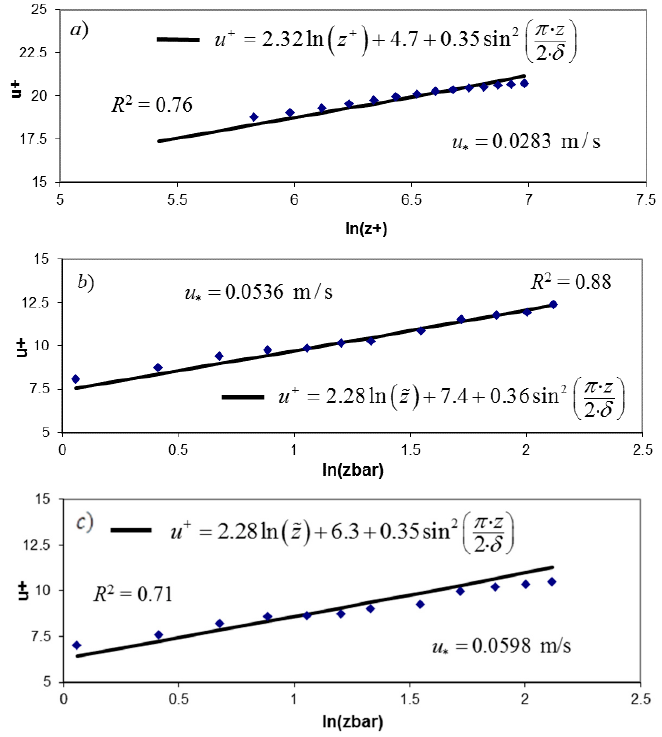
Figure 3. Measured normalised flow velocity profile over ( a ) smooth bed (Test 1), ( b ) rough bed (Test 2), and ( c ) water-worked bed (Test 3).